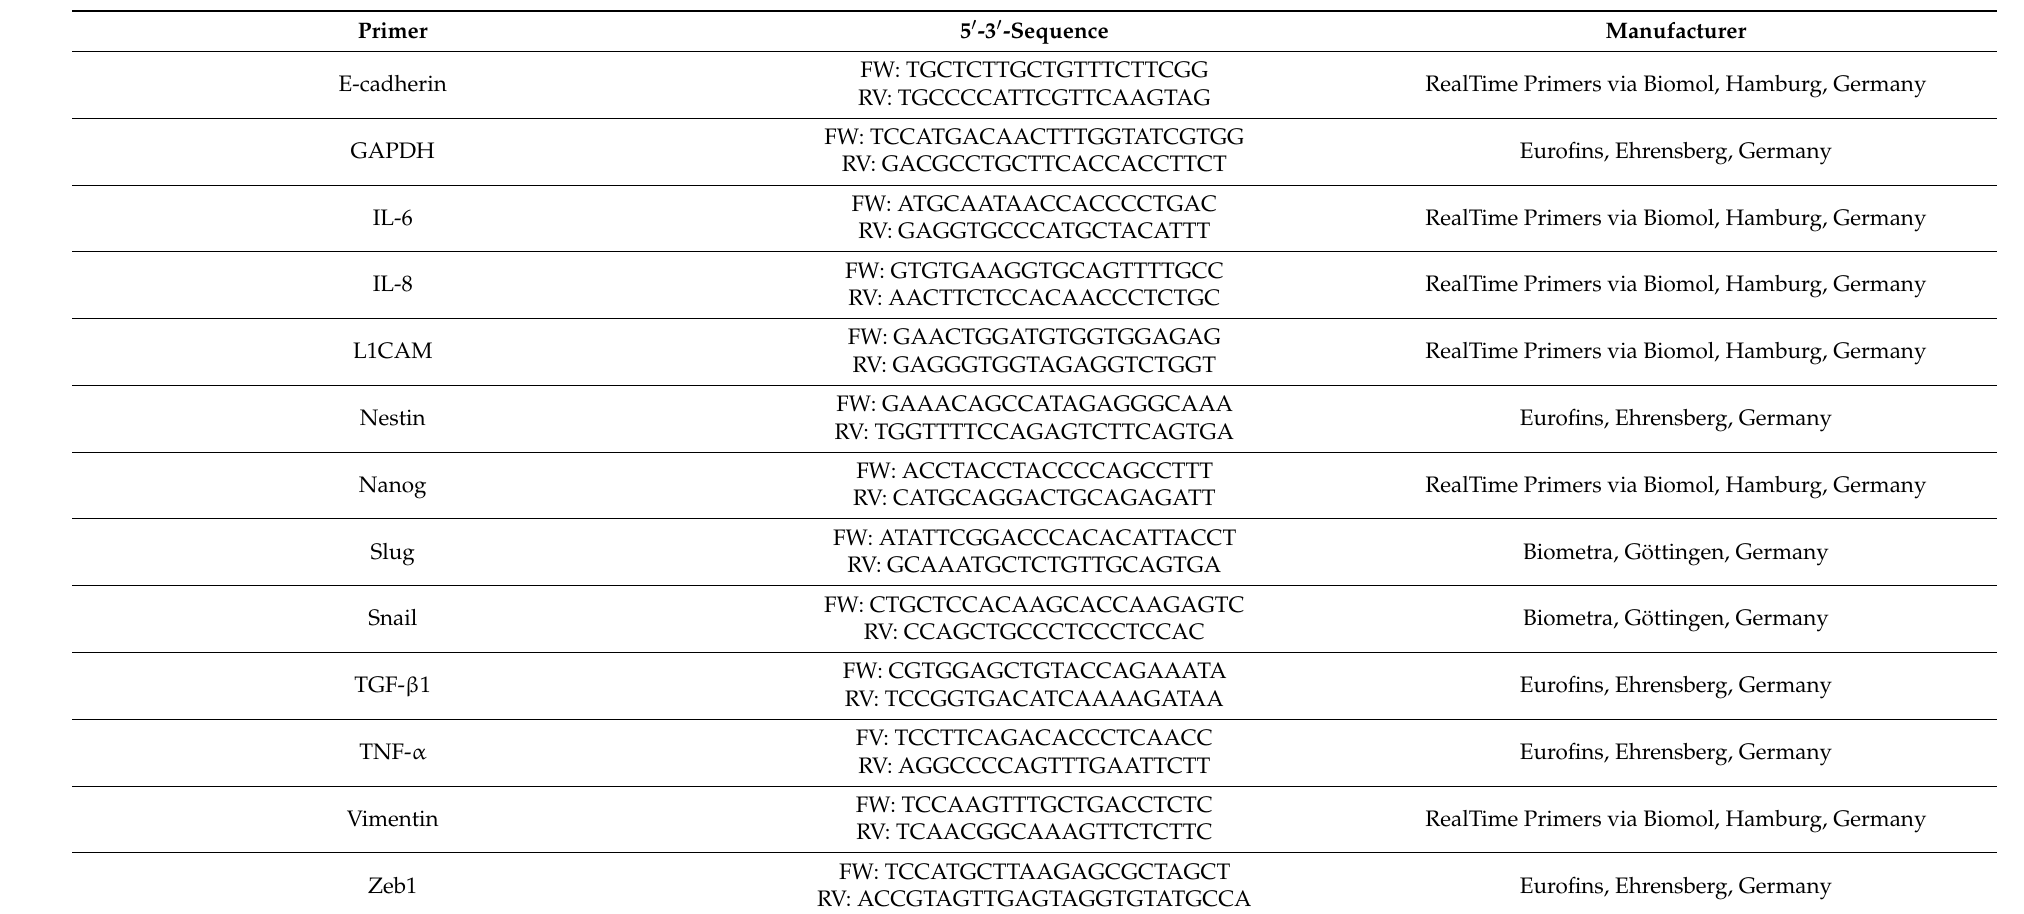
Table 2. Primer and Primer